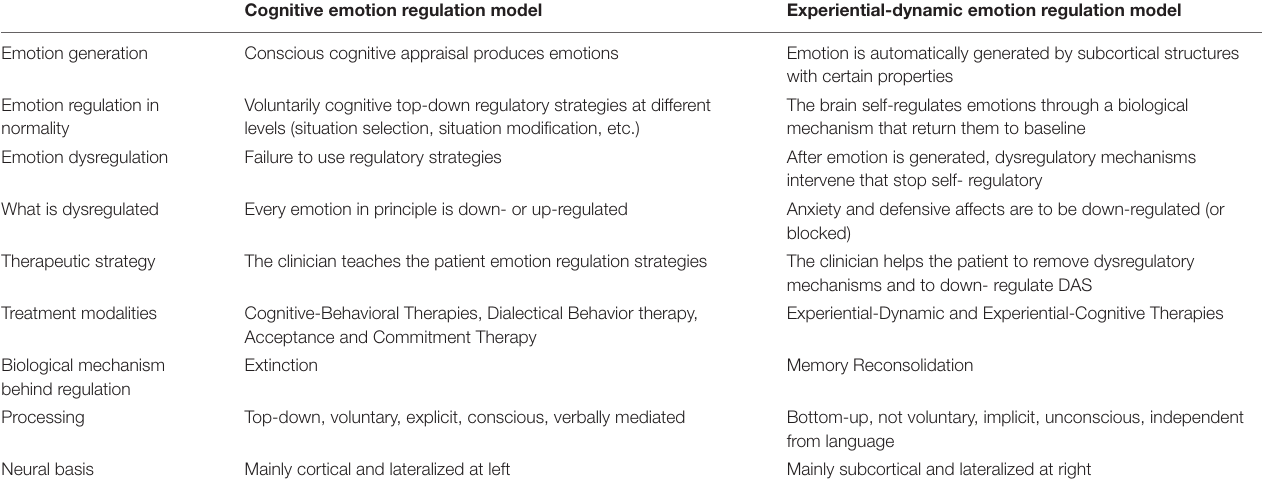
TABLE 1 | Comparing two models of emotion regulation. Cognitive emotion regulation model Experiential-dynamic emotion regulation